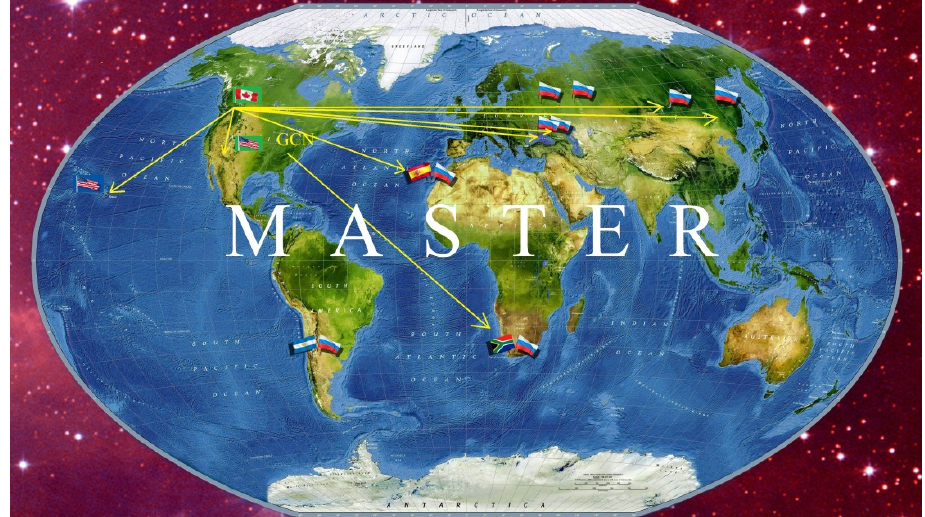
Figure 1. Scheme of MASTER interaction with sites in Canada, Hawaii and New Mexico CHIME/FRB [1–4], Gemini North [52], VLA [77] to search FRB 180916.J0158+655 optical source. Observations of SGR/FRB 200428.J1935+2154 were carried out using alerts from the Gamma Center Network site at NASA. The physical map was taken from http://observ.pereplet.ru/ (accessed on 1 March 2021);the stellar background was made by MASTER.